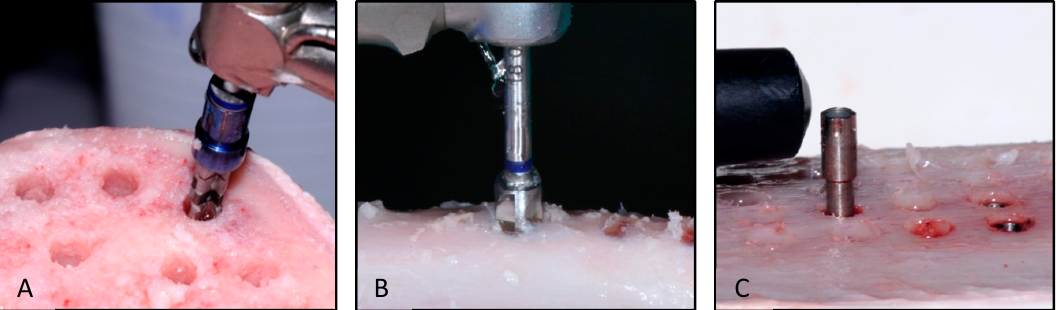
Figure 2. Implant site preparation; ( A )—Pilot drill and 10 mm stop for implant bed depth control, ( B )—cortical drill, ( C )—RFA measurement.